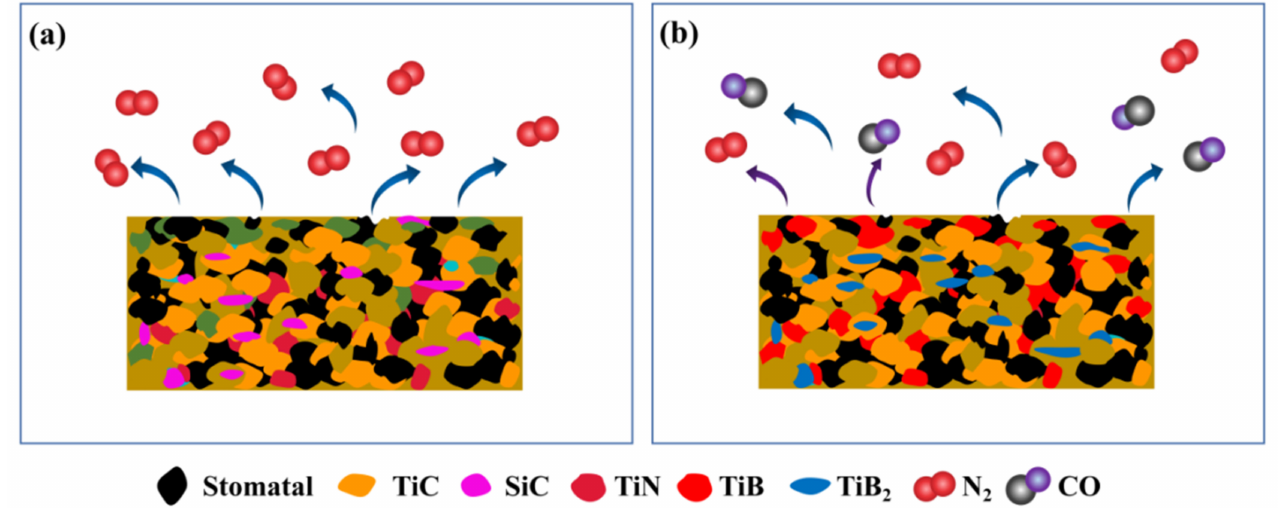
Figure 9. Schematic diagram of the influence of gas on a TiC matrix. ( a ) Effect of Si 3 N 4 addition on the matrix, ( b ) Effect of BN addition on the